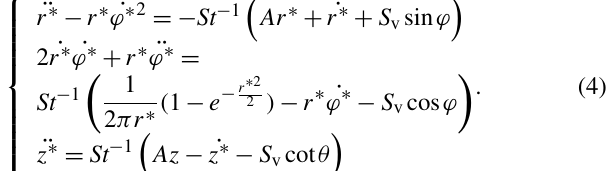
Table 2. Existence of equilibrium points with respect to A and S v body.